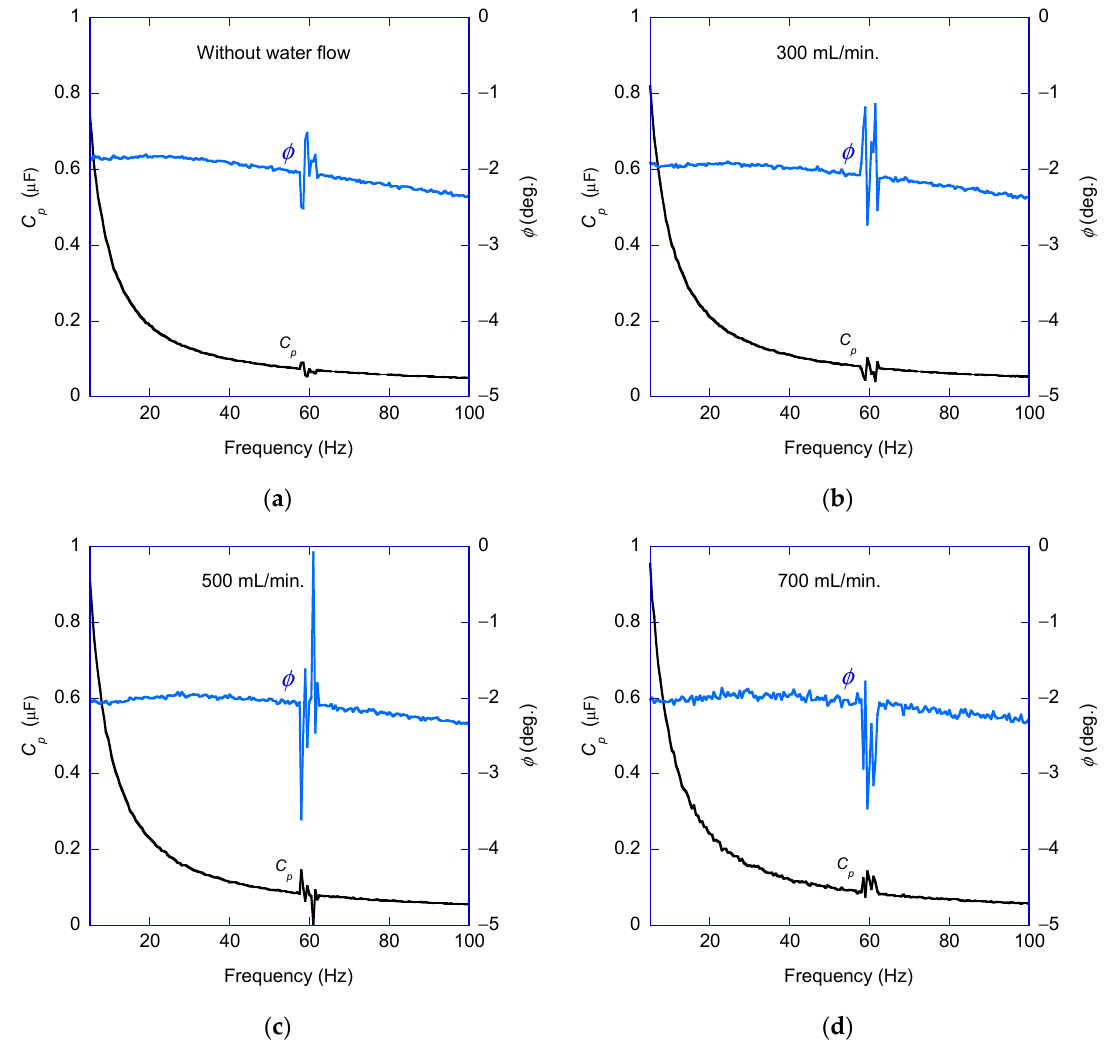
Figure 7. Soil apparent capacitance C p and phase di ff erence φ between V and I as a function of applied current frequency: ( a ) without water flow; ( b ) water flow of 300 mL/min; ( c ) water flow of 500 mL/min; ( d ) water flow of 700 mL/min.